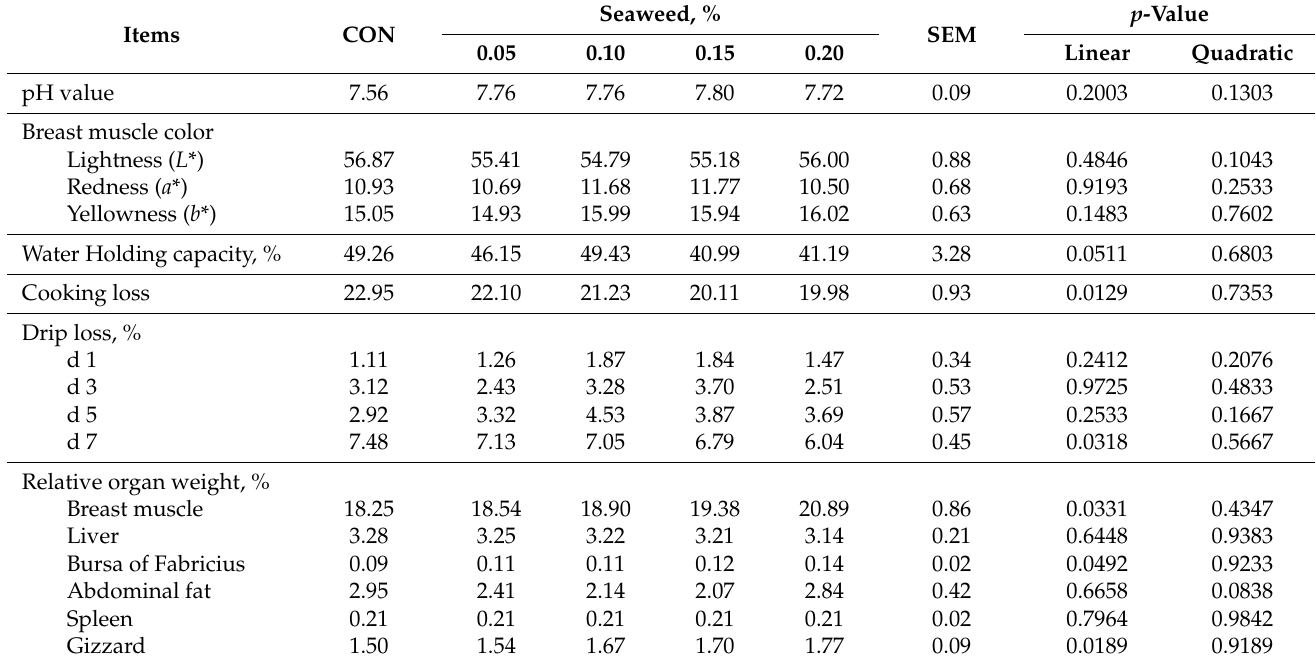
Table 9. The effect of red seaweed supplementation on meat quality in broilers 1